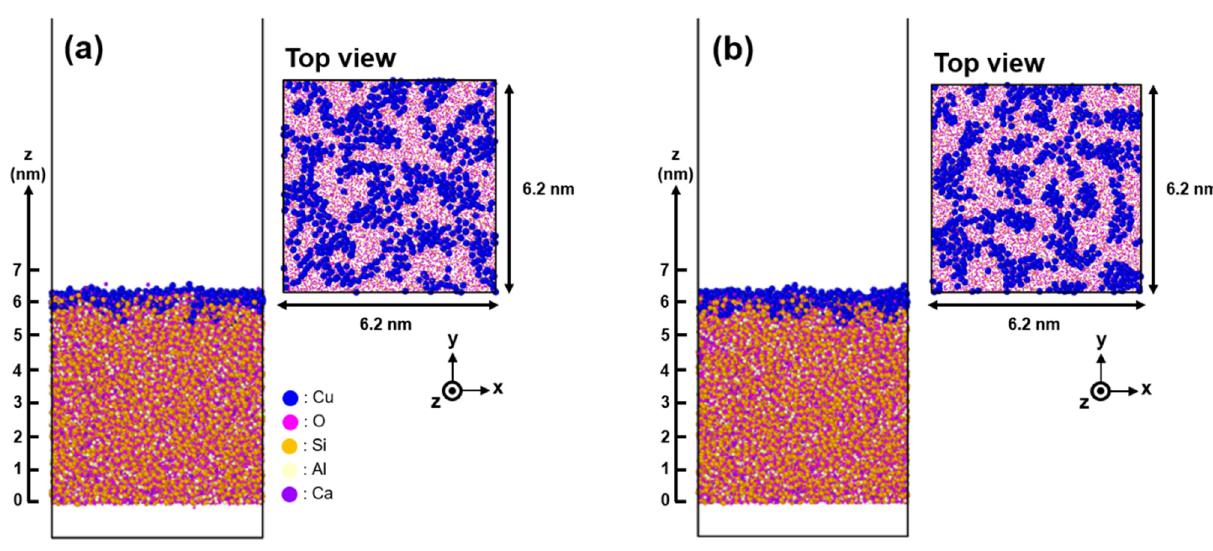
Figure 3. Comparison of IR on CAS substrate between ( a ) high E Inc and ( b ) low E Inc cases. Atom sizes of glass elements were reduced in the top view for emphasizing the adsorption of Cu atoms.